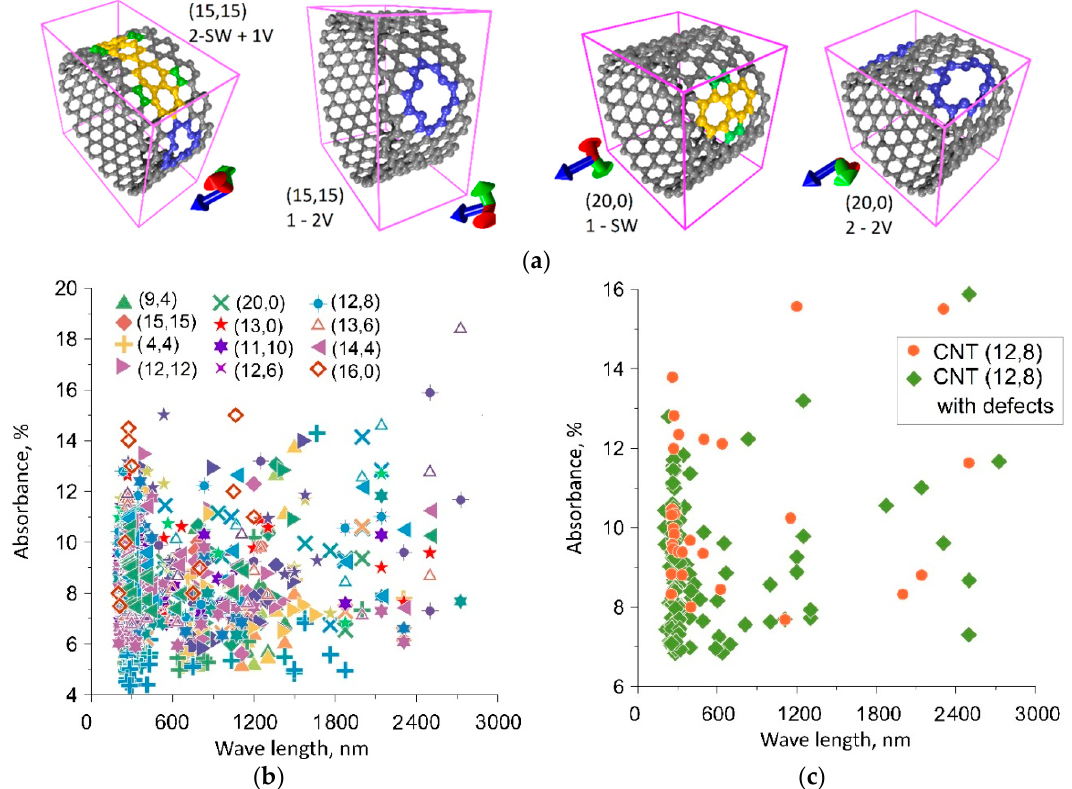
Figure 1. Absorption of the energy of electromagnetic waves by defective single-walled carbon nanotubes (SWCNTs): ( a ) Examples of atomistic models of defective SWCNTs (lilac box corresponds to a supercell); ( b ) distribution of the absorption coe ffi cient maxima for the defective SWCNTs with a diameter of 0.6–2 nm; ( с ) distribution of the absorption coe ffi cient maxima for defect-free and defective SWCNT